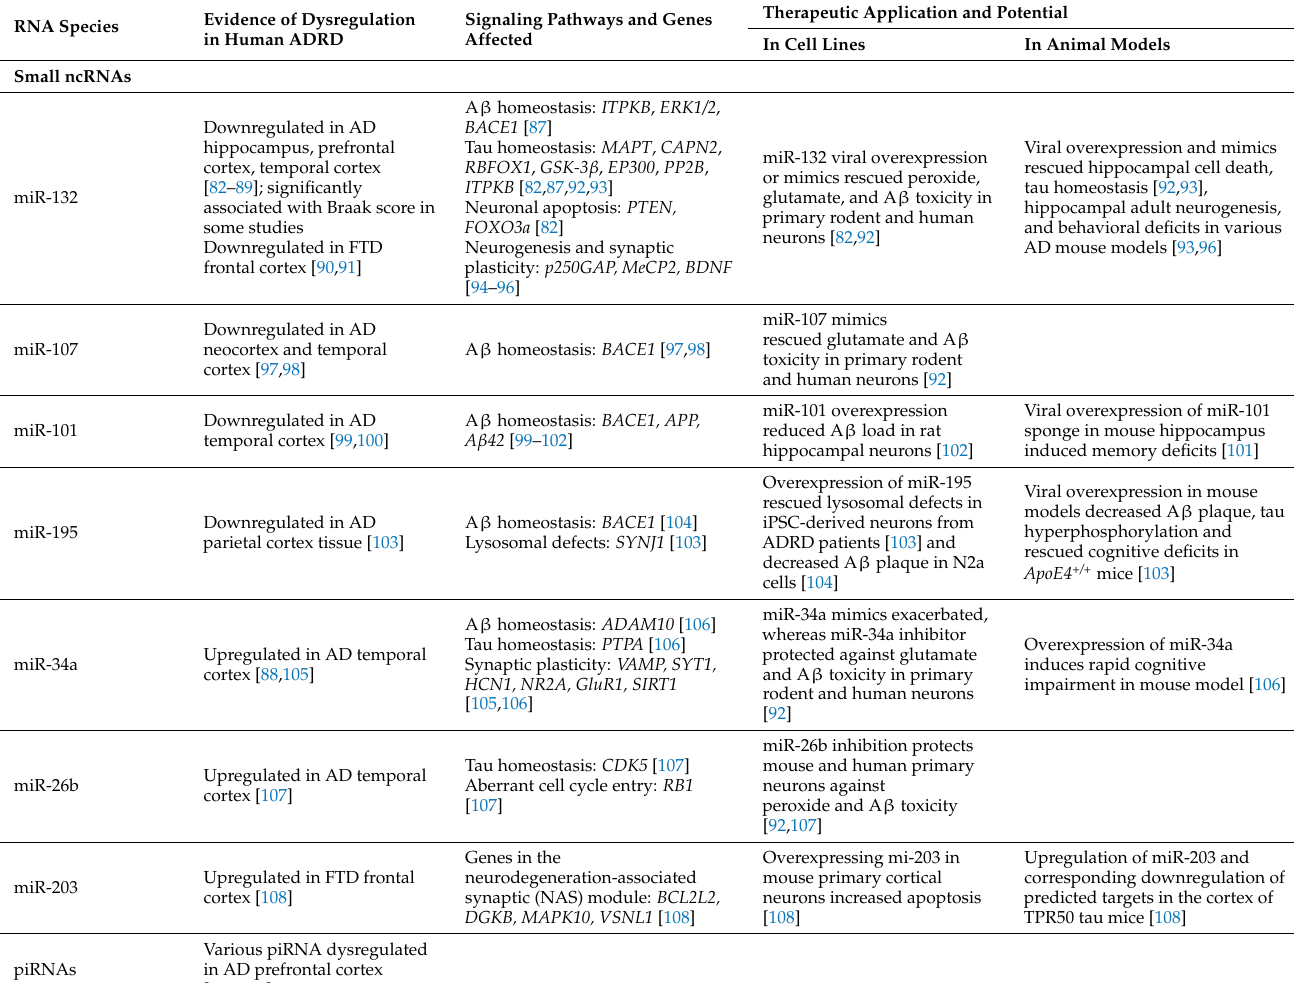
Table 2. Some ncRNAs dysregulated in ADRD with evidence for therapeutic potential. Therapeutic Application and Potential Signaling Pathways and Genes RNA Species Evidence of Dysregulation in Human ADRD Affected In Cell Lines In Animal